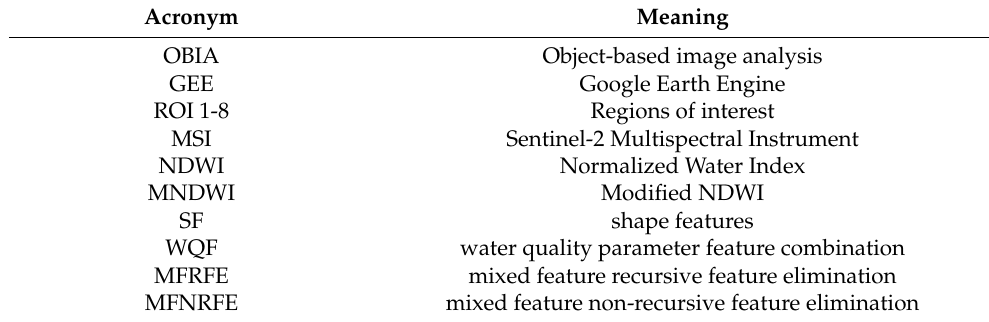
Table 1. List of acronyms used in the